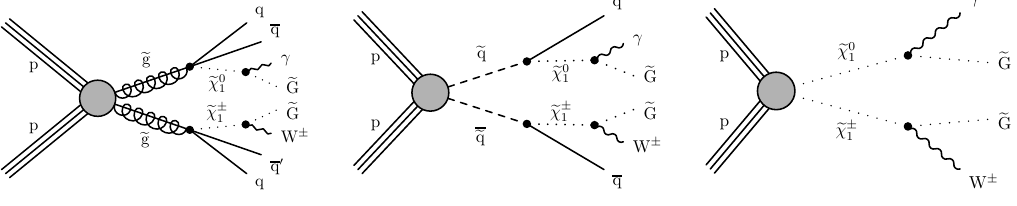
Figure 1 . Diagrams showing the production and decay modes of the signal models T5Wg (left), T6Wg (center), and TChiWg (right) considered in this